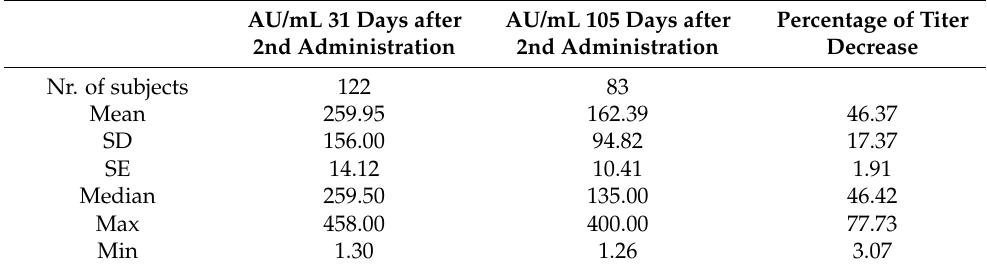
Table 2. Anti-SARS-CoV-2 antibody titers (AU/mL) mean, standard deviation (SD), standard error (SE), median, and range (Max-Min) modifications at 31 and 105 days after the administration of the second dose of anti-SARS-CoV-2 vaccine.